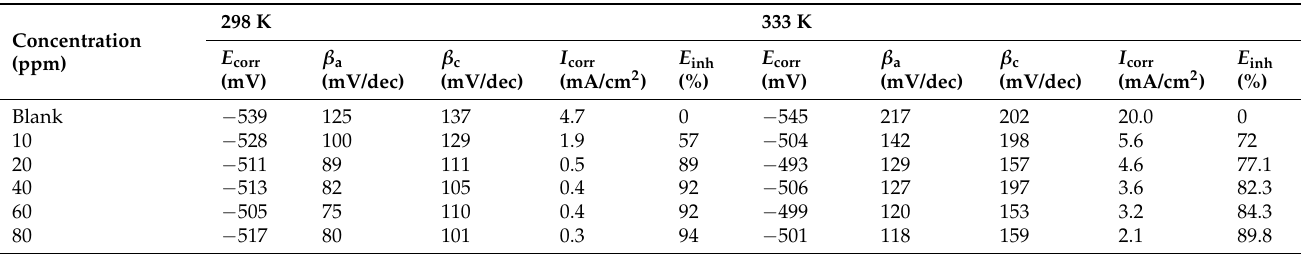
Table 3. PDP parameters of low-carbon steel corrosion in 1 M HCl in the absence and presence of CoO/Co 3 O 4 NPs at 298 and 333